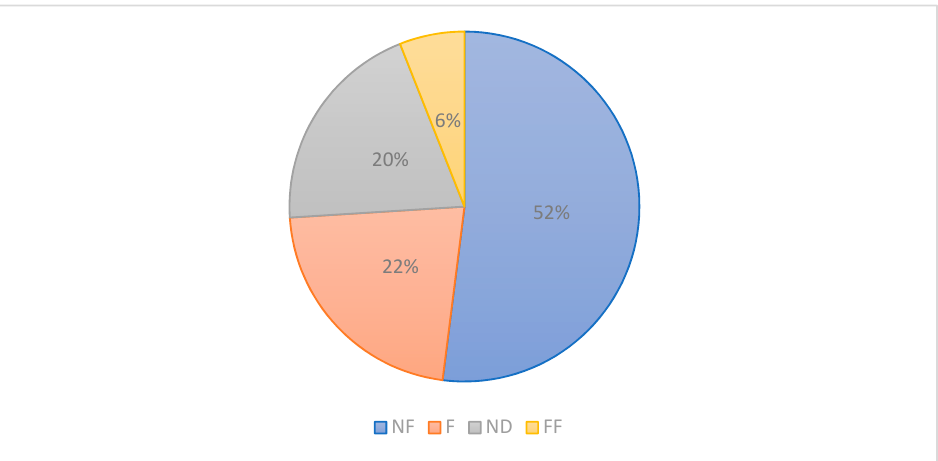
Figure 5. Results of the experiments in the morning for the morning circadian chrono-type.